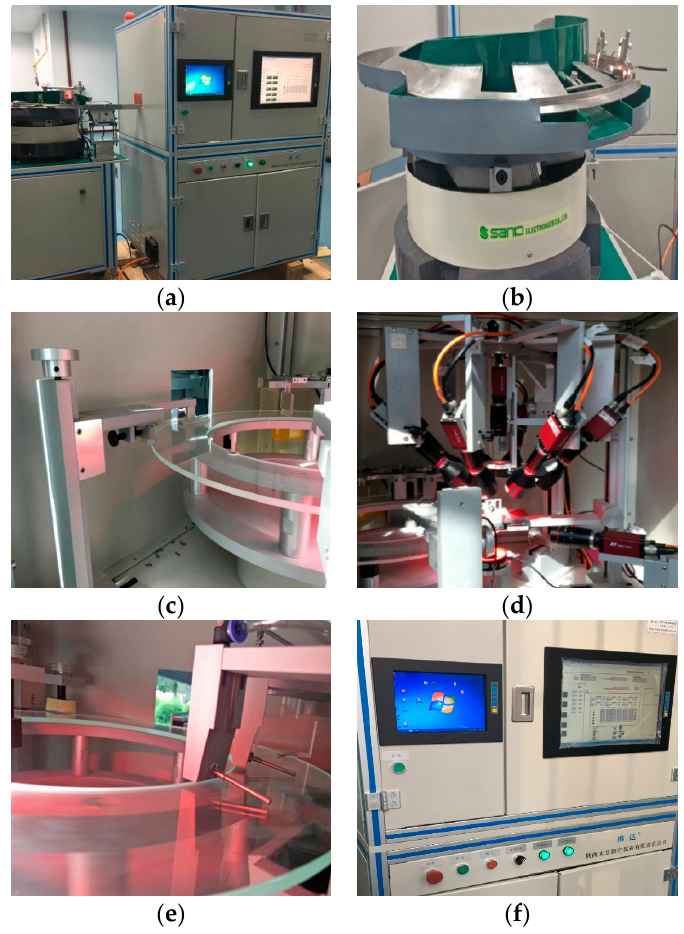
Figure 3. The prototype of the magnetic ring detection system: ( a ) system appearance; ( b ) feeding device; ( c ) precision turntable and slide rail limit device; ( d ) group vision machine and light source; ( e ) sorting device; ( f ) host computer and console.